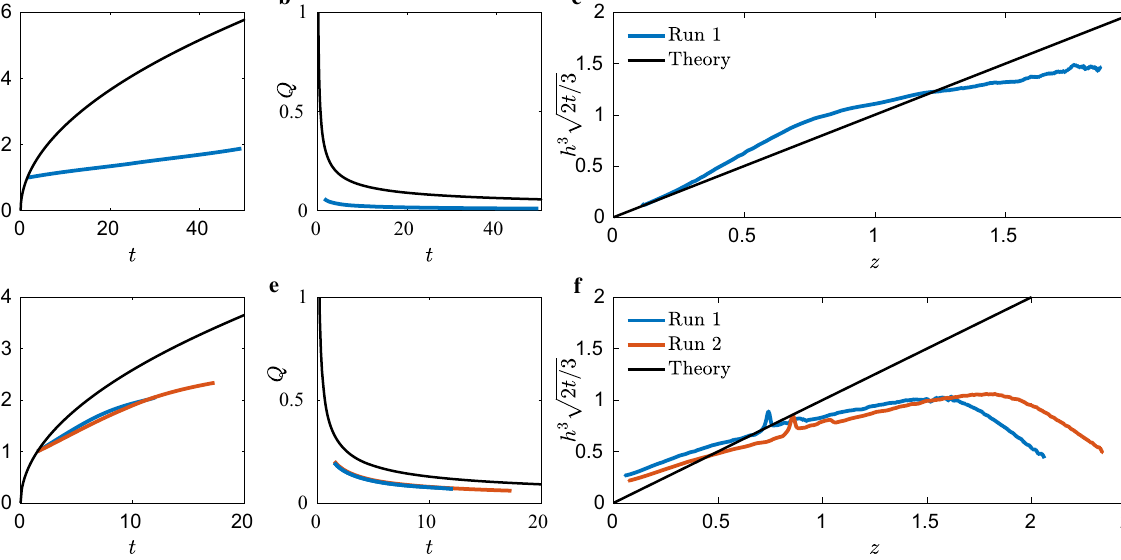
Fig. 9 ICF-6 data. Draining from a – c small- and d – f big-ends. a , d present advancing bulk meniscus location z 2 ( t ), b , e volumetric fl ow rate Q ( t ), and c , f the self-similar time-averaged interface height pro fi le h 3 (2 t /3) 1/2